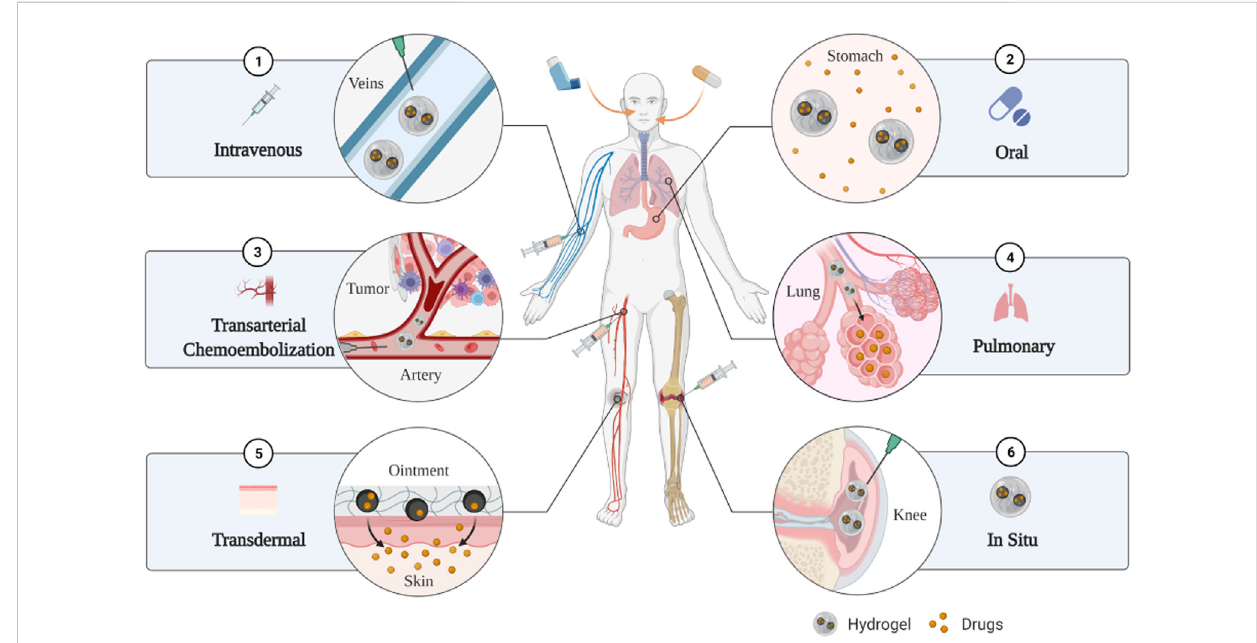
FIGURE 2 The hydrogels have multiple delivery routes such as intravenous injection, oral delivery, transarterial chemoembolization, pulmonary delivery, transdermal delivery, in situ injection and in situ